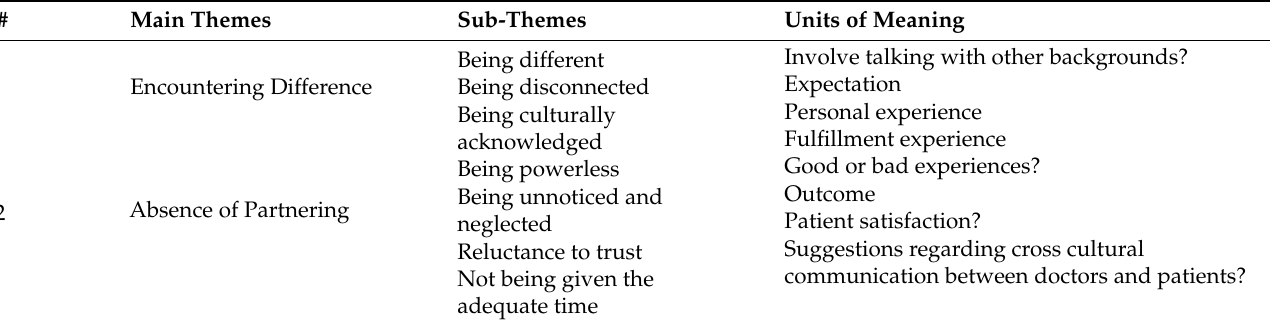
Table 3. Main Themes and